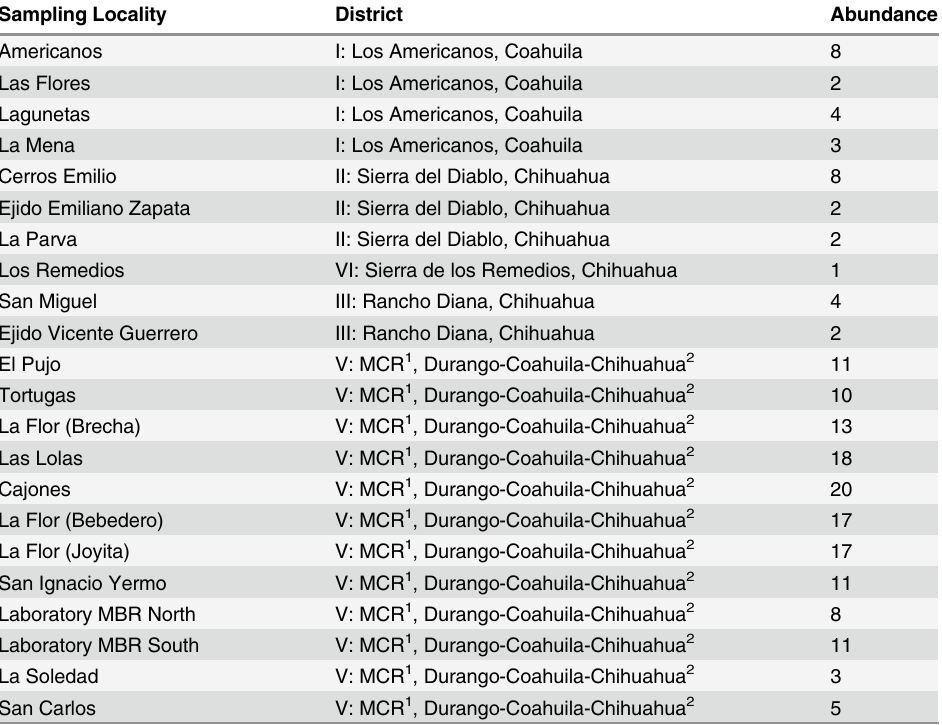
Table 3. Validation for the Inverse Regression Model between Mahalanobis distance to the ENC and burrow abundance.